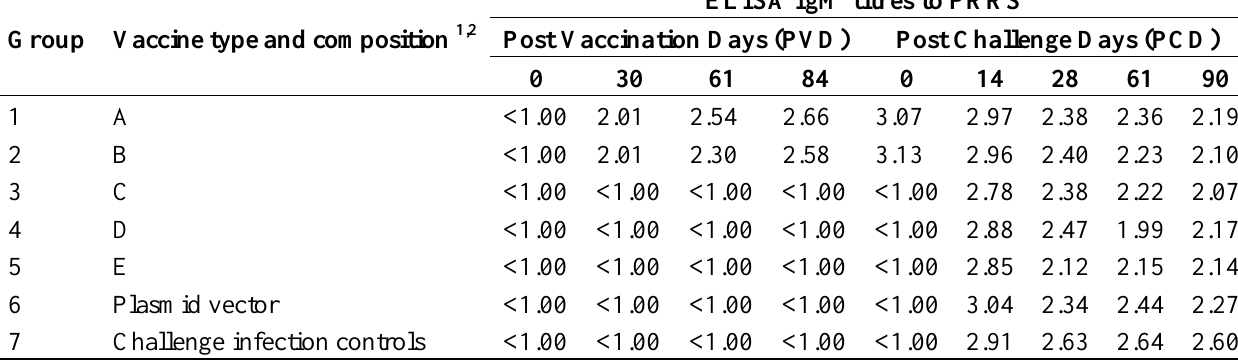
Table 5. ELISA Immunoglobulins M (IgM) response of pigs immunised with experimental PRRS DNA vaccines and challenge infected with virulent